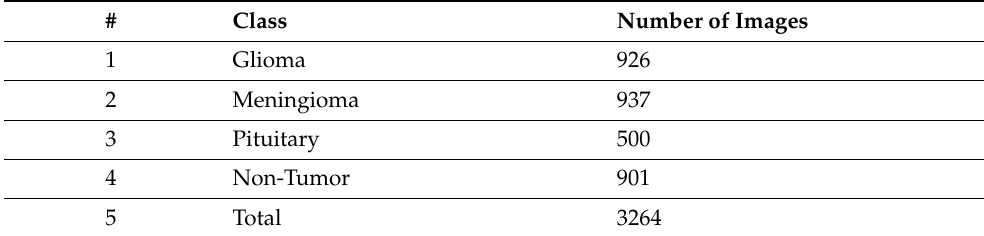
Table 1. Data distribution as per class label.